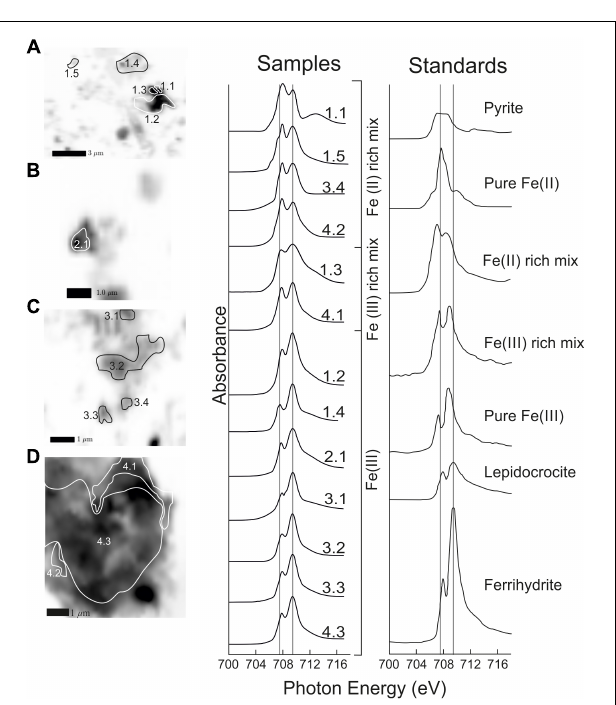
FIGURE 5 | Iron XAS spectra Fe rich regions of VDVF plume particles showing Fe oxidation state. Optical density maps (A–D) show Fe rich areas of interest (1–4). Spectra are classified as in von der Heyden et al. (2012) where spectra can be either pure Fe(II), pure Fe(III), or a mix. Ferrihydrite, lepidocrocite and pyrite standard spectra for comparison are taken from Toner et al. (2009) and von der Heyden et al. (2012). Scale is shown by black bars and text in left corner of